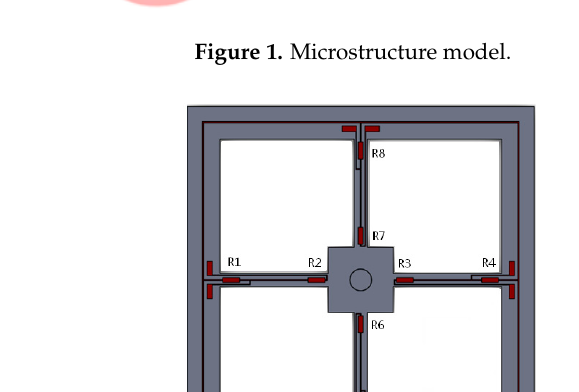
Figure 2. Distribution of the piezoresistors.